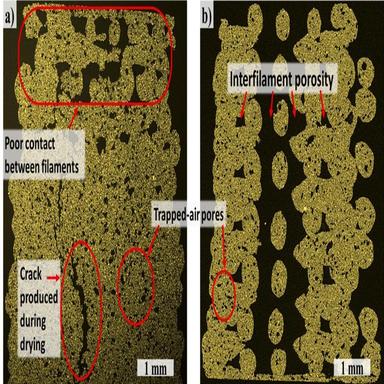
Representative BSE – SEM images of the cross-section of a) monolithic, and b) 3D-lattice samples at a view field of 5000 µm.